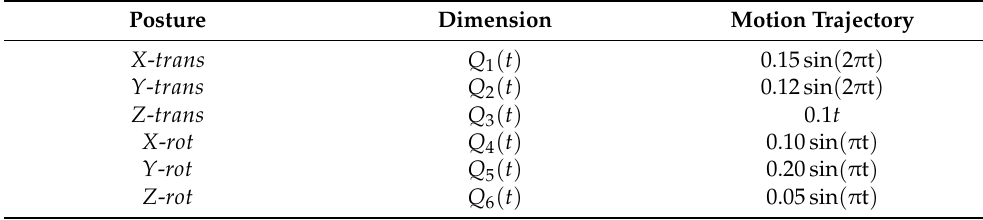
Table 6. The six-dimensional